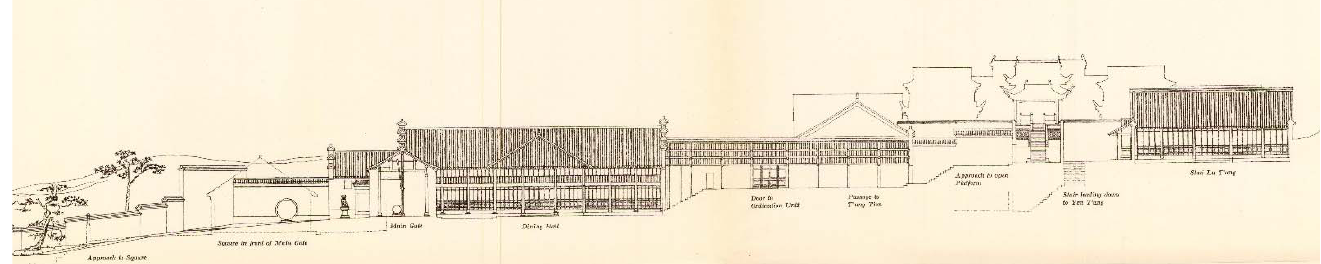
Figure 6. Section of Longchang Monastery, showing the Main Gate, the Ordination Platform Unit and the Open ‐ Air Platform (Prip ‐ Møller 1937, Pl.